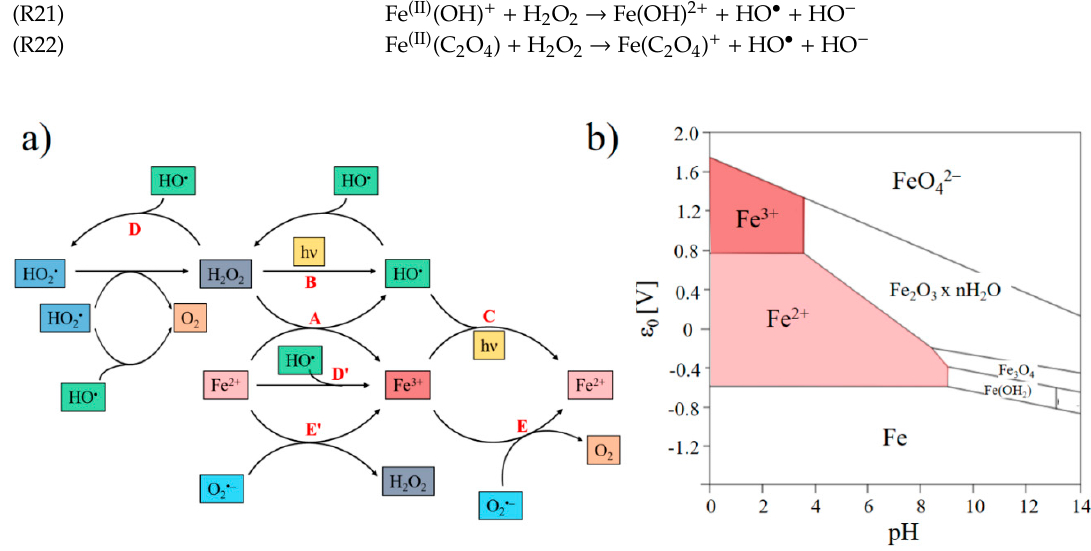
Figure 3. ( a ) Iron chemistry and photochemistry (adapted from Long et al. [120]); ( b ) Pourbaix diagram of iron: speciation as a function of pH and redox